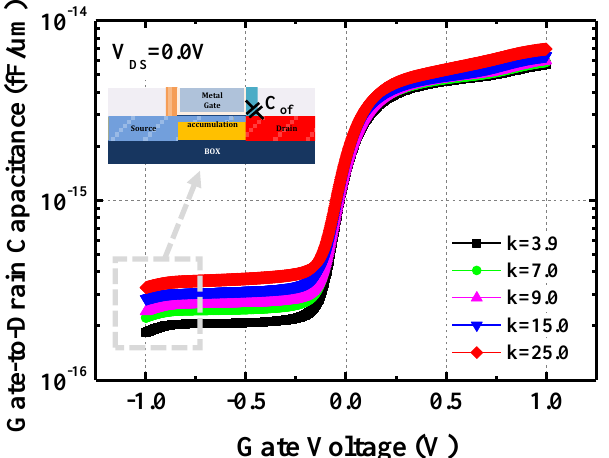
Figure 6. Gate-to-drain capacitance-voltage characteristics at V DS = 0.0 V with different κ values of spacer. Outer fringing gate-to-drain capacitance (C of ) can be extracted at V GS = − 1.0 V based on ideal junction.